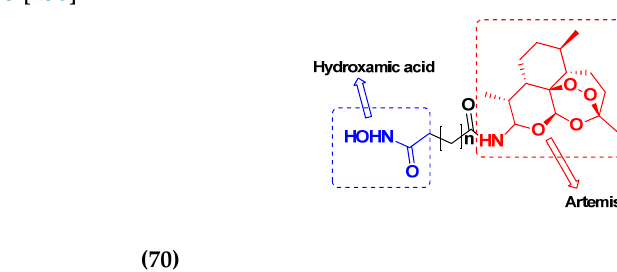
Figure 67. Structure of hydroxamic acid with artemisinin hybrid derivatives ( 70 ). Table 55. In vitro cytotoxic activities of hydroxamic acid with artemisinin hybrid compounds 70 ( a – c ).